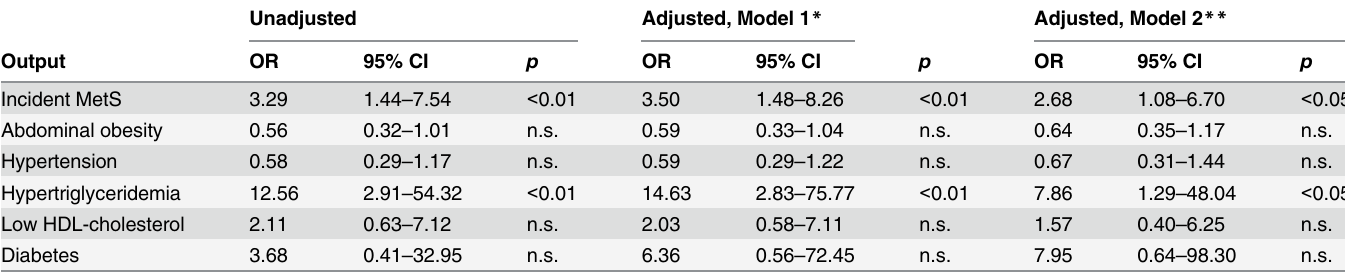
Table 3. Odds ratios and 95% confidence intervals of high stress level on incident cases of metabolic syndrome and its